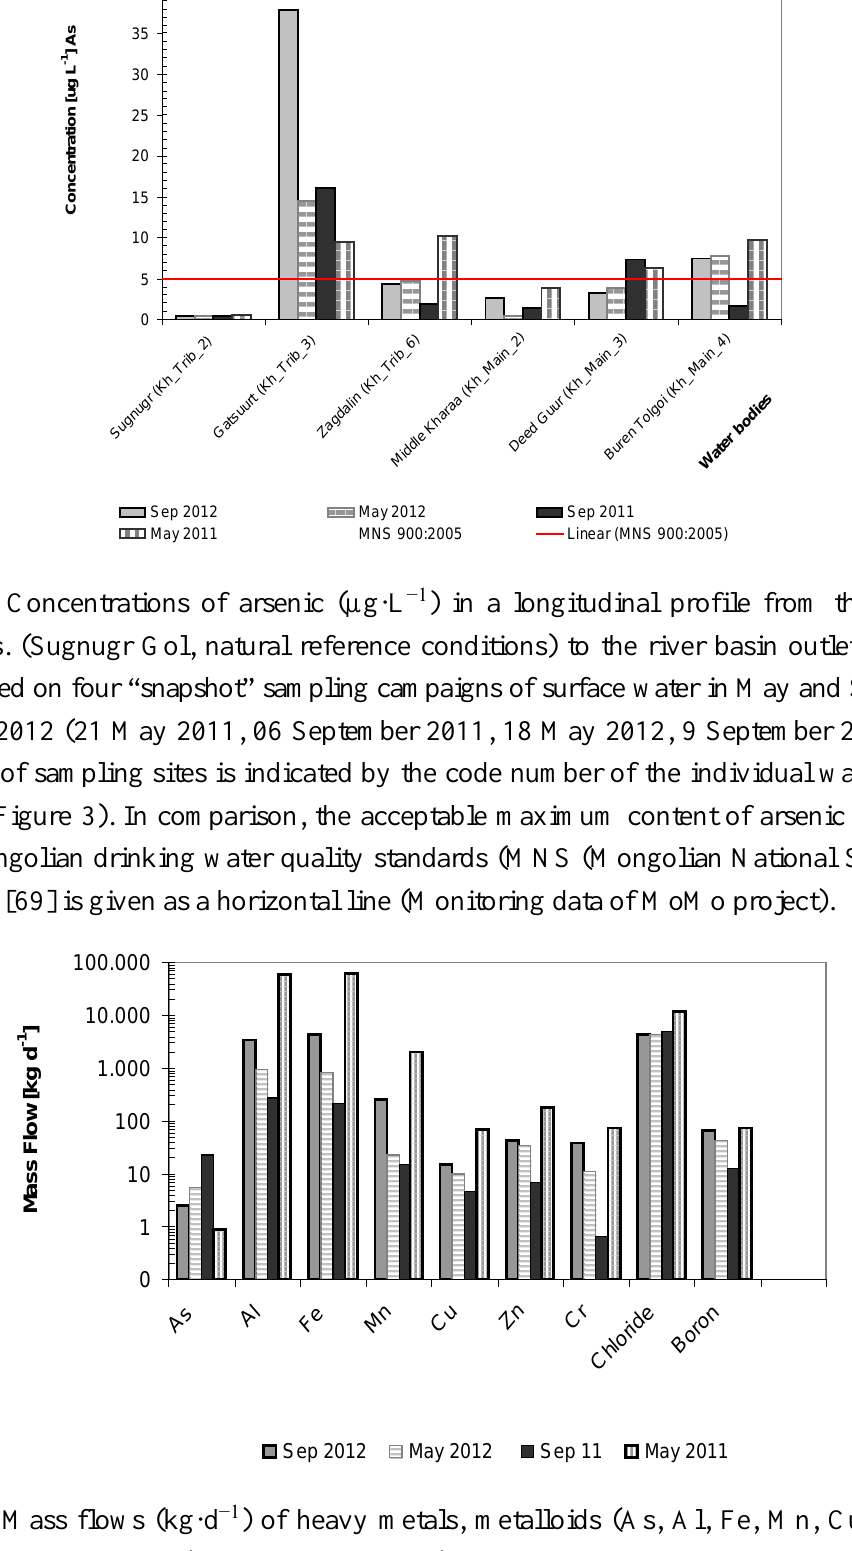
Figure 6. Mass flows (kg·d −1 ) of heavy metals, metalloids (As, Al, Fe, Mn, Cu, Zn, Cr) and pollution indicators (Chloride and Boron) at Buren Tolgoi close to the KRB outlet (Lower Kharaa Kh_Main_4, Sel_Kh10_001) based on four “snapshot” sampling campaigns in May and September 2011 and 2012 (21 May 2011, 06 September 2011, 18 May 2012, 9 September 2012). For exact locations of the water body and sampling site refer to Figure 3, Tables 1 and 5. (Monitoring data of MoMo